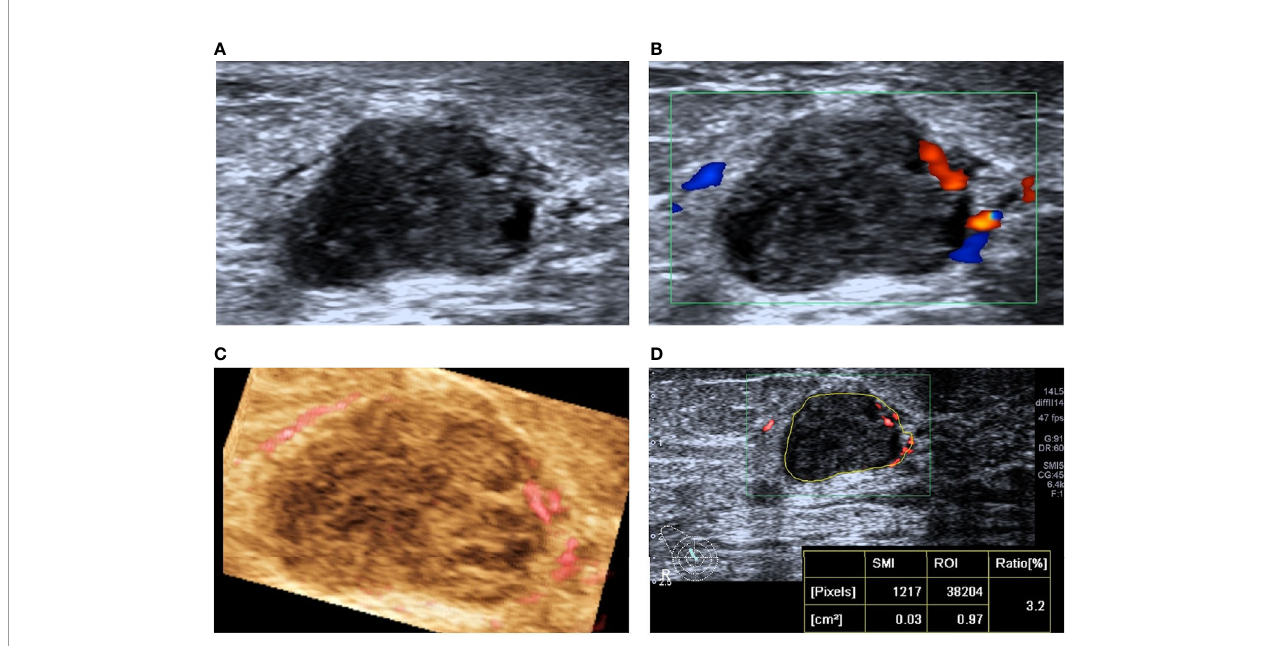
FIGURE 4 | A 78-year-old woman with intraductal papilloma was downgraded from BI-RADS 4A to BI-RADS 3 after SMI assessment. (A) Two-dimensional ultrasound shows an irregular hypoechoic lesion. (B) CDFI shows the striated blood fl ow signal around the lesion. (C) SMI shows a dotted and linear VA. (D) The vascular index was measured by delineating the lesion edge on the plane with the most abundant blood vessels, and the value was